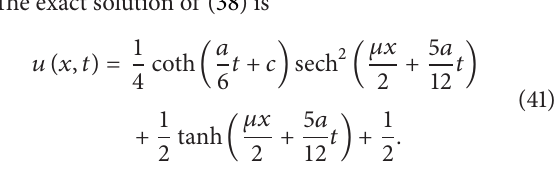
Table 3 lists the absolute errors for problem (38)